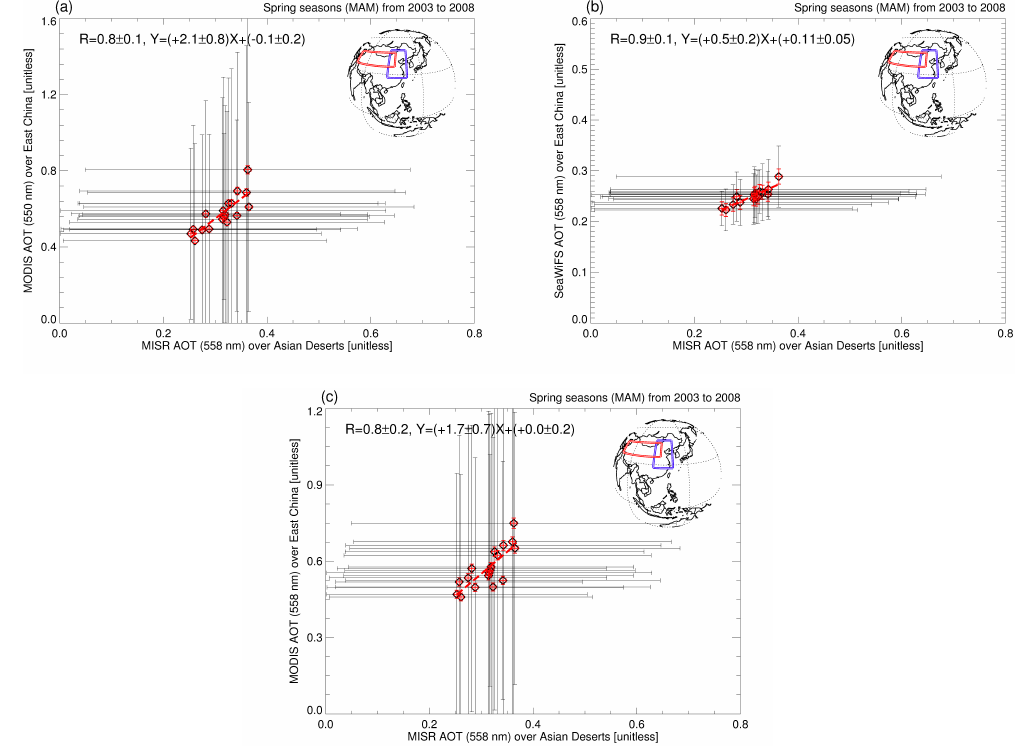
Figure 15. Plots of the correlations between MISR (Terra) AOT over Asian deserts and (a) MODIS (Terra), (b) SeaWiFS (OrbView-2), and (c) MODIS (Aqua) AOTs over eastern China in spring seasons from 2003 to 2008. Black and red error bars show natural variability and standard retrieval error within a 95% confidence level, respectively.